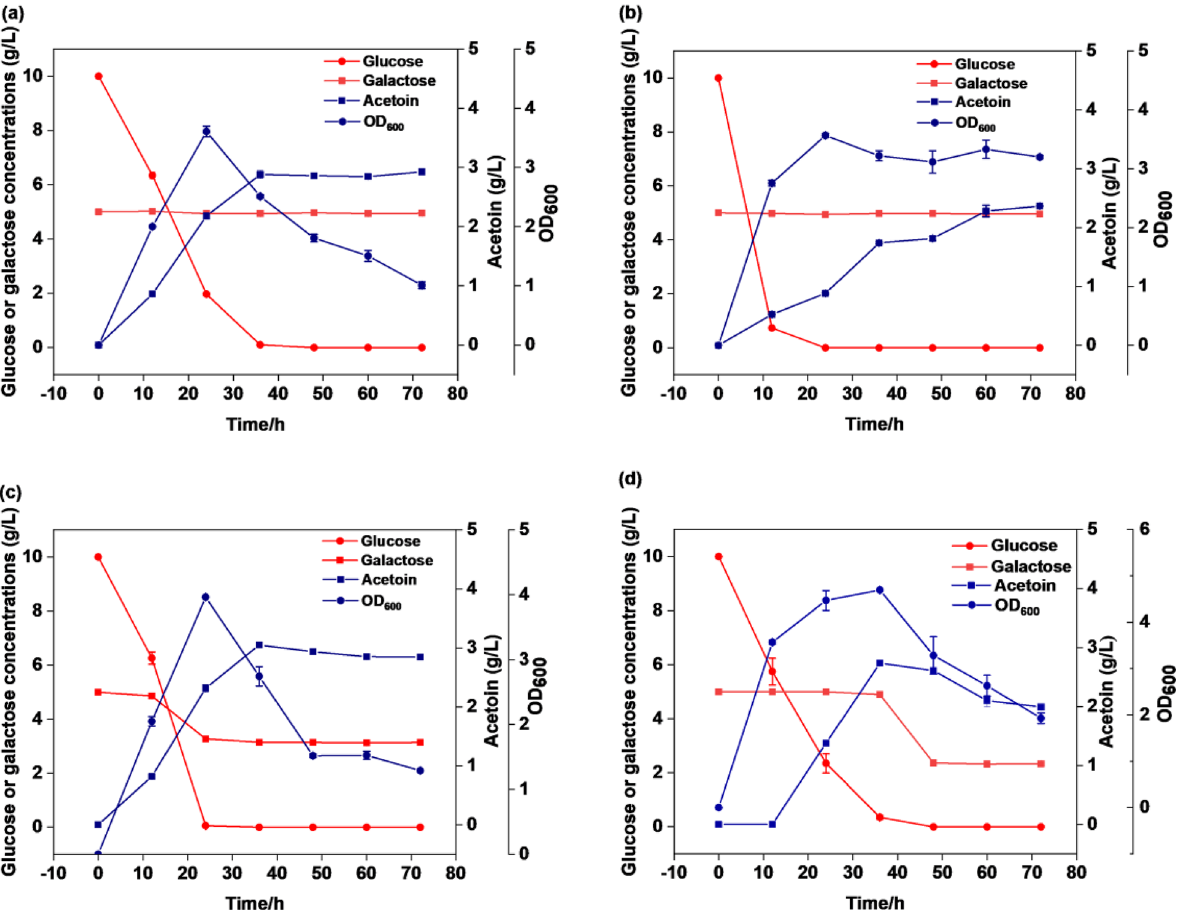
Fig. 4 Recombinant strain fermented acetoin under microaerobic conditions in M9 mixed sugar medium (10 g/L glucose BS01-pMA5; b BS02; c BS03; d